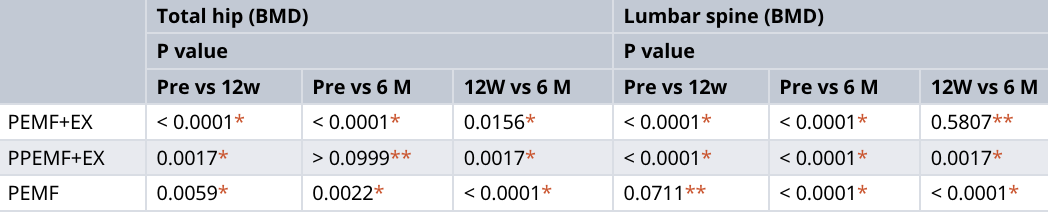
Table 3. Comparison between measurements in each treatment group.